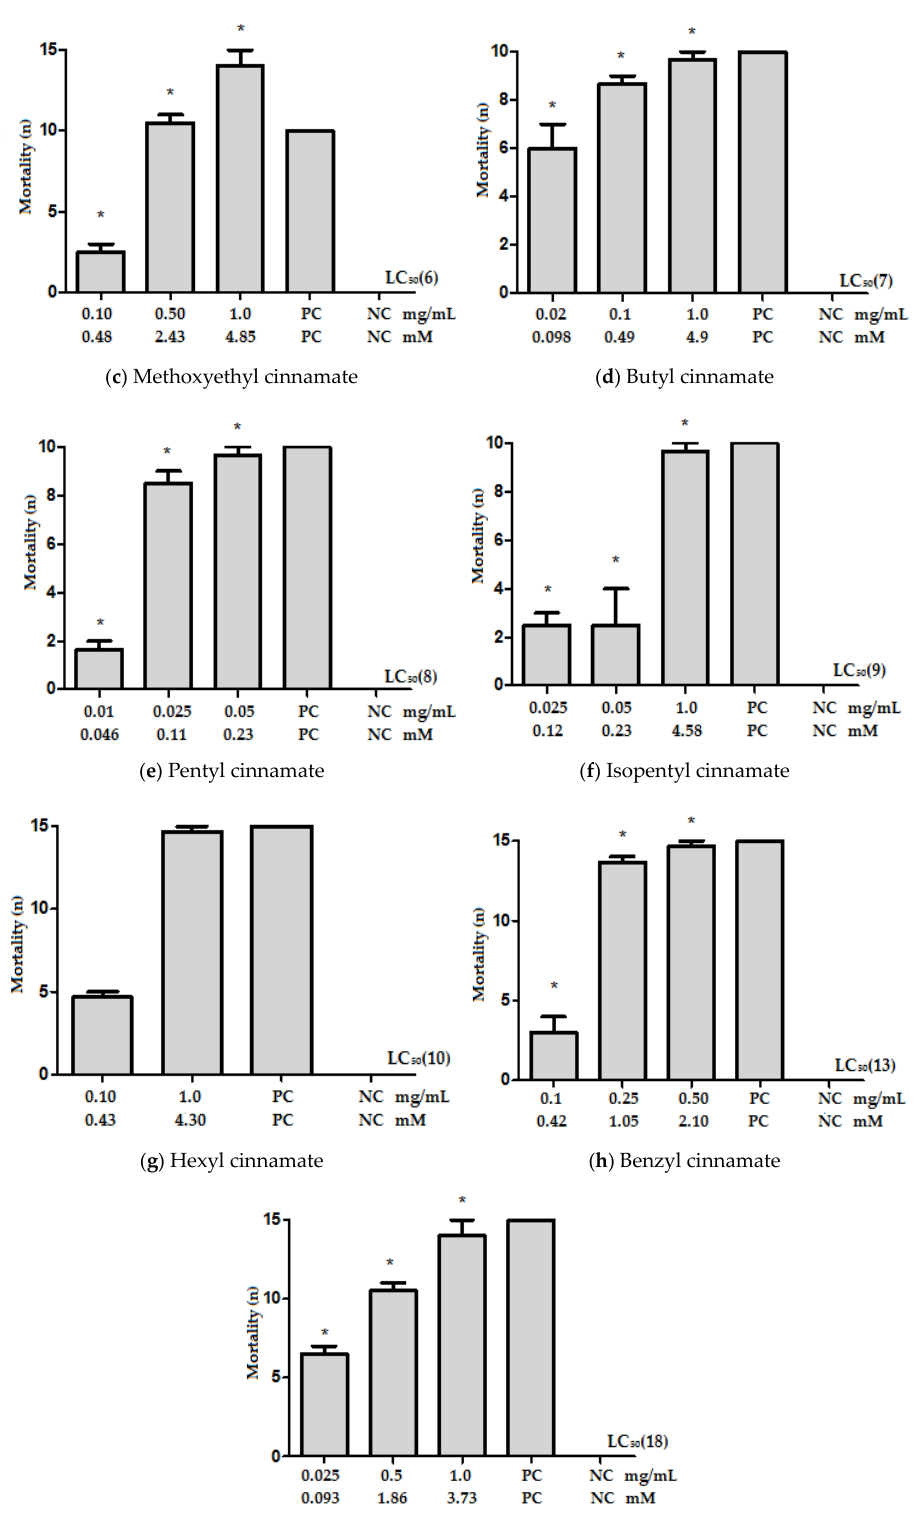
Figure 1. The best larvicidal activity among different cinnamic acid derivative concentrations: ( a ) ethyl cinnamate, ( b ) isopropyl cinnamate, ( c ) methoxyethyl cinnamate, ( d ) butyl cinnamate, ( e ) pentyl cinnamate, ( f ) isopentyl cinnamate, ( g ) hexyl cinnamate, ( h ) benzyl cinnamate and ( i ) 3-metoxybenzyl cinnamate against Ae. aegypti larvae after 24 h (expressed in mg/mL and convert mM). PC = positive control, NC = negative control. (*) Indicates results that are significantly different from the controls.